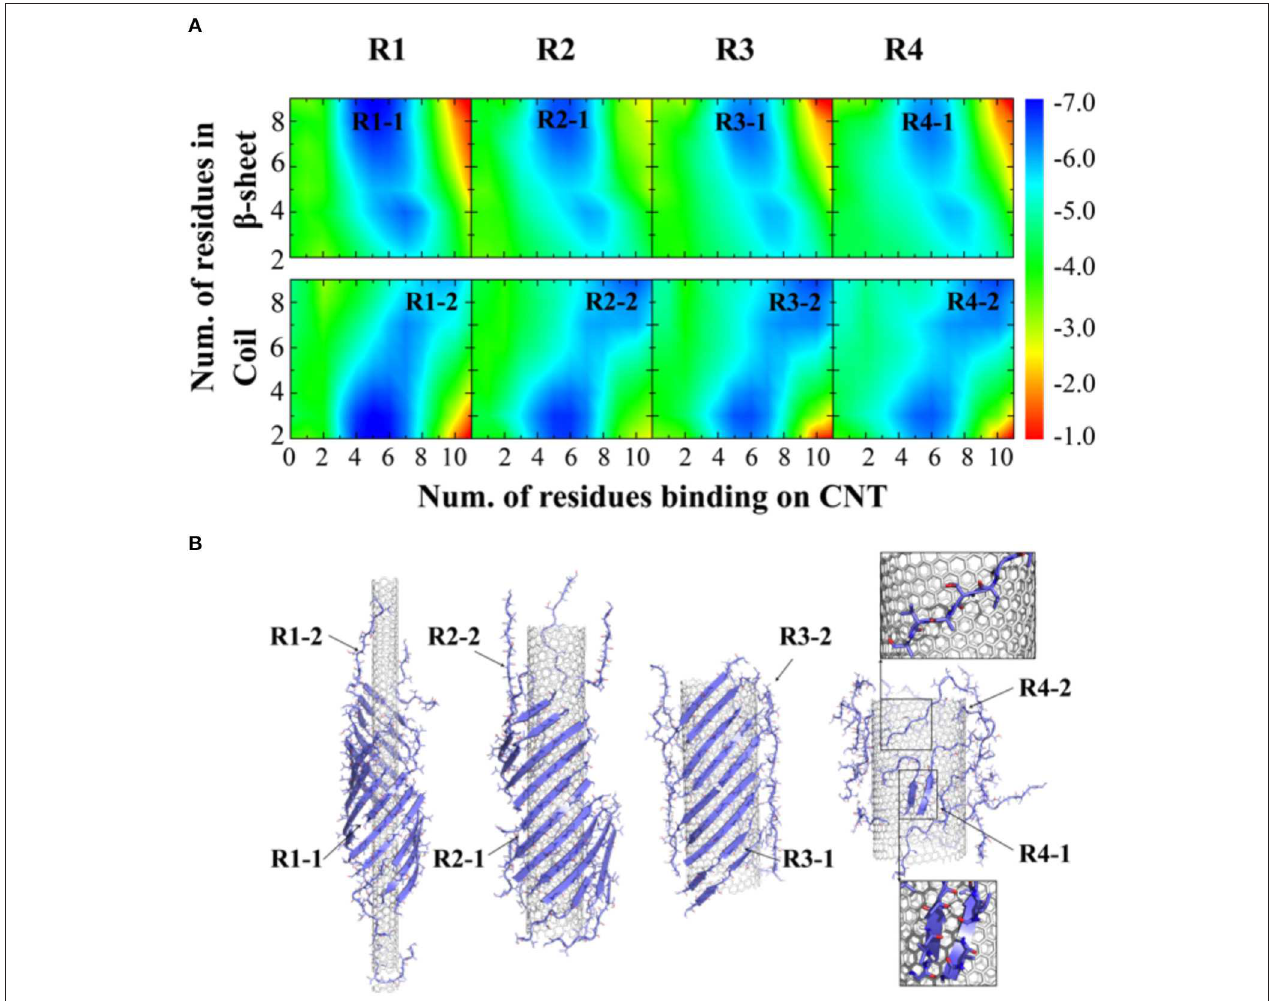
FIGURE 3 | Thermodynamics analysis of NACore assembly in the presence of CNTs of different radii. (A) The two-dimensional potential of mean force as a function of the number of residues binding CNT and the number of residues adopt β -sheet (top) or coil (lower) per peptide. CNT radii increased s from R1 to R4. (B) Typical snapshots from corresponding simulations illustrated the loss of β -sheet super-coil structures and the transition from β -sheet to coil as CNT radius increases. Peptides corresponding to different free energy basin in (A) were highlighted by